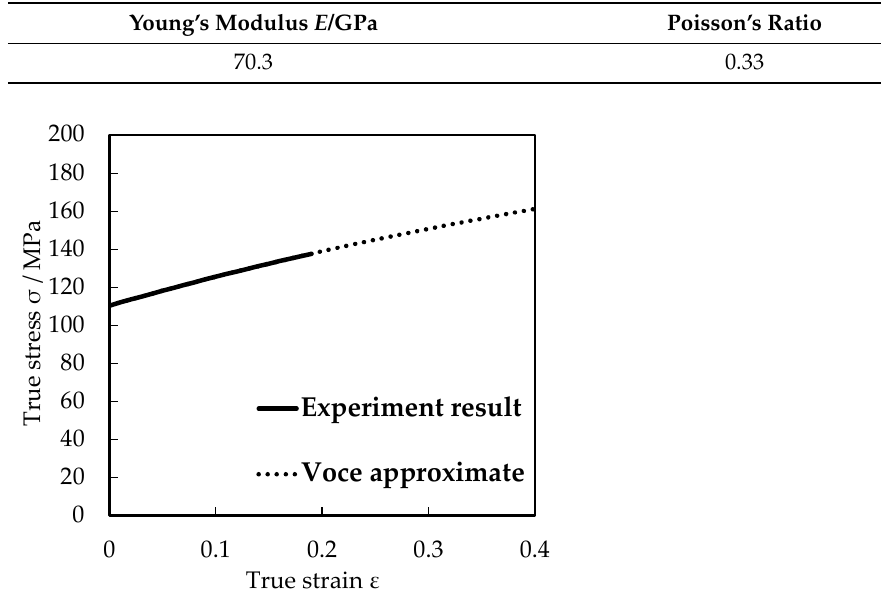
Table 3. Mechanical properties of AA1050.